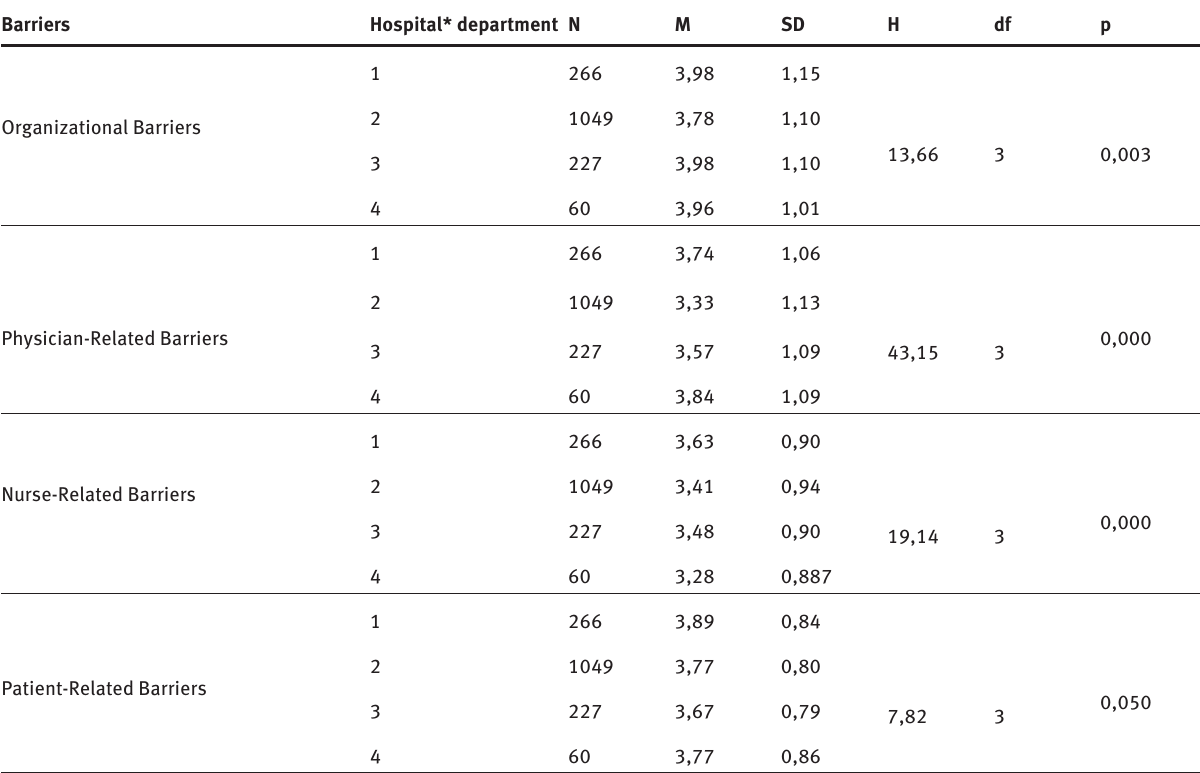
Table 8: Hospital department and perception of problems by